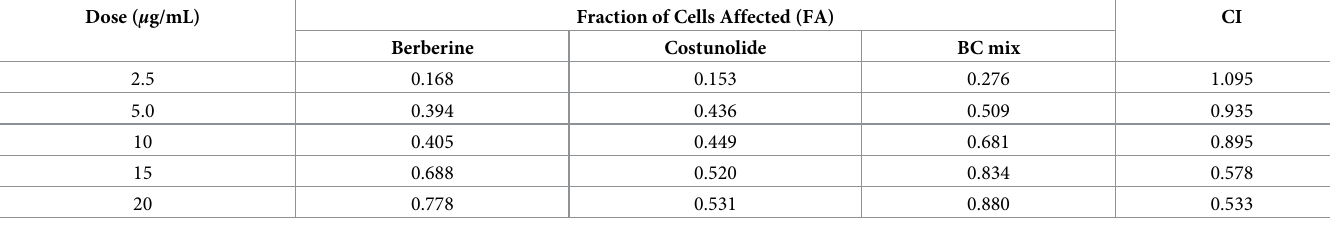
Abbreviations are as follows: FA, Fraction of cells with growth affectedin response to Berberine and /or Costunolide treated vs. uncreated cells; CI, combination Index. CI < 1.0 indicates